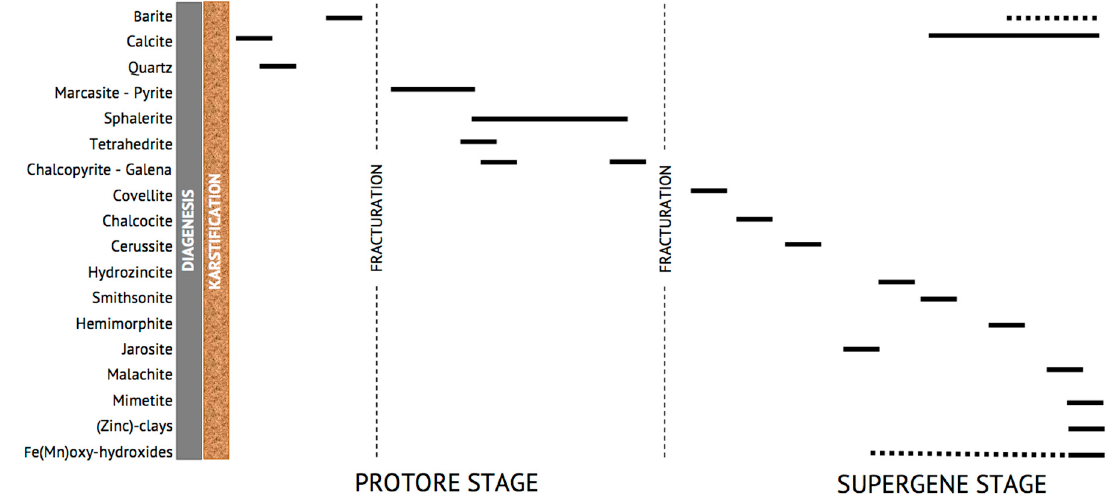
Figure 10. Mineral paragenetic sequence of Ba-(Zn-Pb) primary and supergene mineralizations in the Caïd area (data of the protore stage from [21]; data of the supergene stage from [21] and this study).